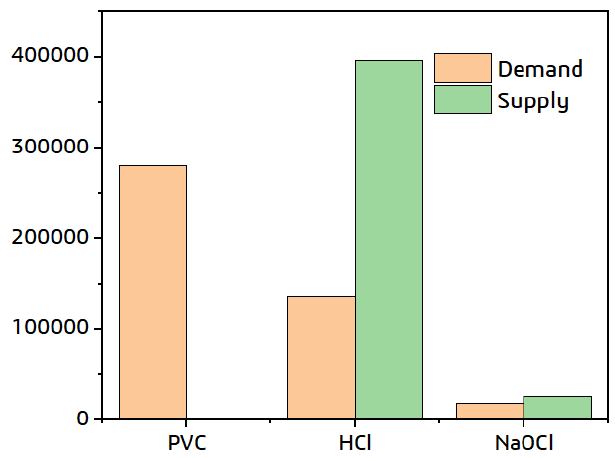
Figure 10. The demand and supply of PVC, HCl, and NaOCl in Bangladesh.